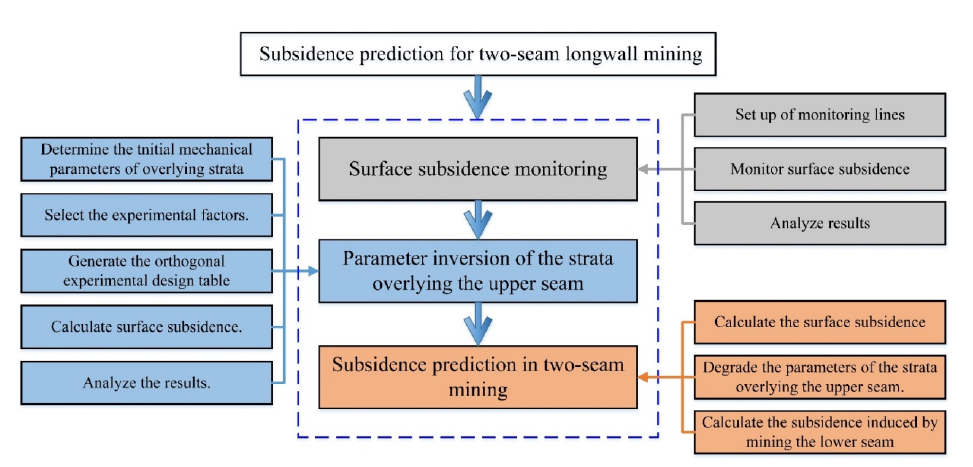
Figure 1. Flow chart of the subsidence prediction method.